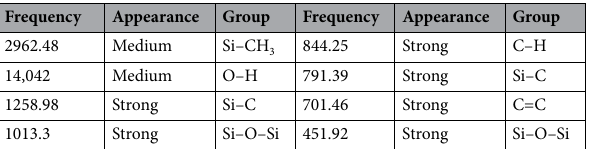
Table 5. The characteristic functional groups of the FTIR spectral bands.